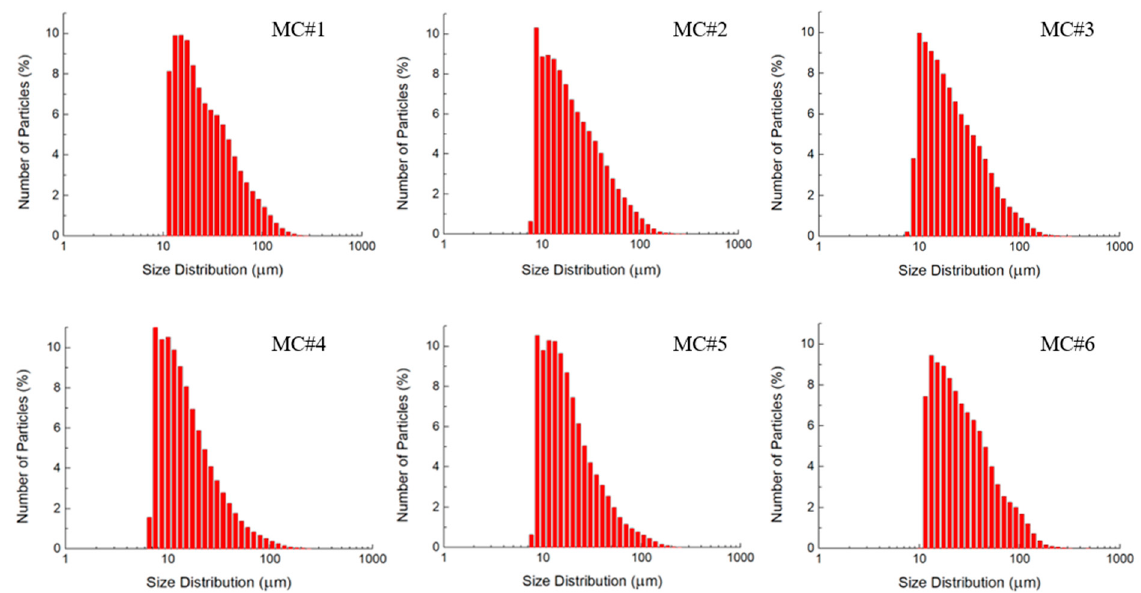
Figure 5. Size distribution bar charts according to the laser diffraction analysis of the dispersions of MC#1–MC#6 GO samples with equal concentration.